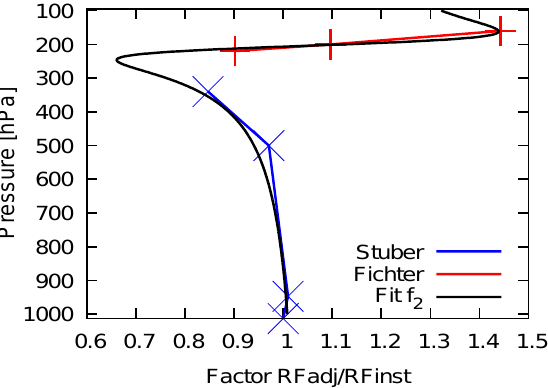
Fig. A3. Height dependence of the relation between instanta- neous and adjusted RF for annual mean RF values of changes in ozone. Data are taken from Stuber (2003) and Fichter (2009). Ozone changes are mainly found in the Northern Hemisphere (see also the